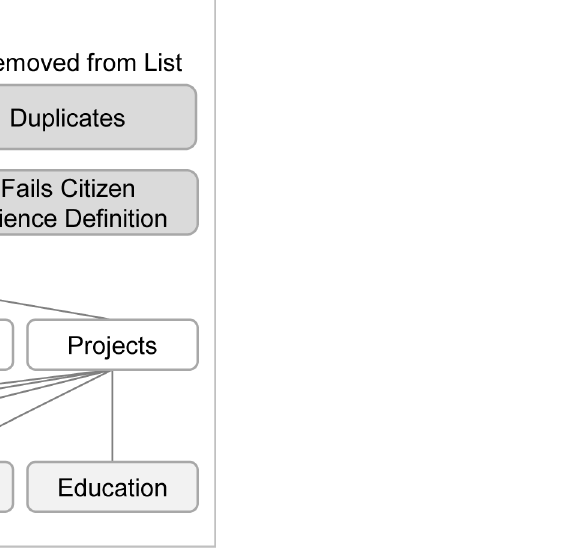
Fig 1. Classifying extracted publications into various